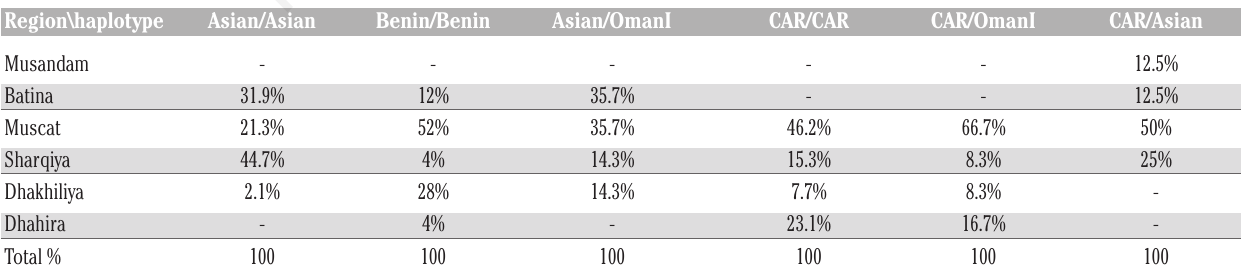
Table 5. The frequency distribution of the 6 most common haplotypes in 6 different regions in Oman. Region\haplotype